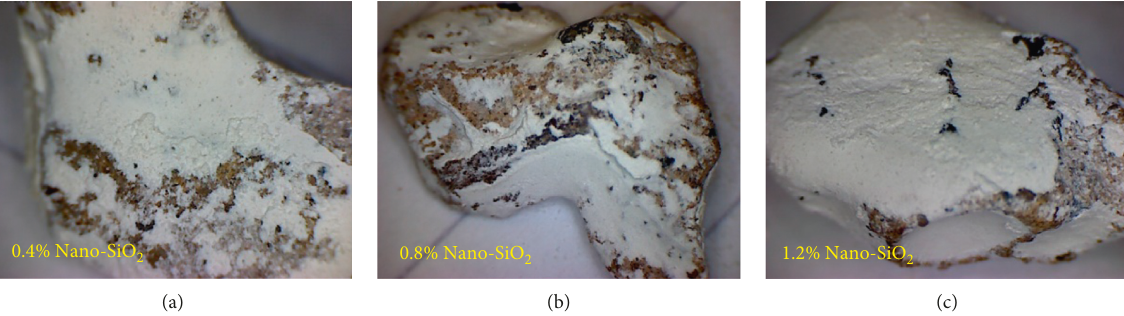
Figure 10: Microscopic images of RA particles with different nanosilica contents: (a) 0.4%; (b) 0.8%; (c) Figure 10. The effect of nanosilica on the surface of the RA particles is clear. The Nanosilica modifies the surface by sealing all the microcracks and filling all the voids. This modification can partly explain the enhancement in the strength gained by adding nanosilica to the mixes with RA.